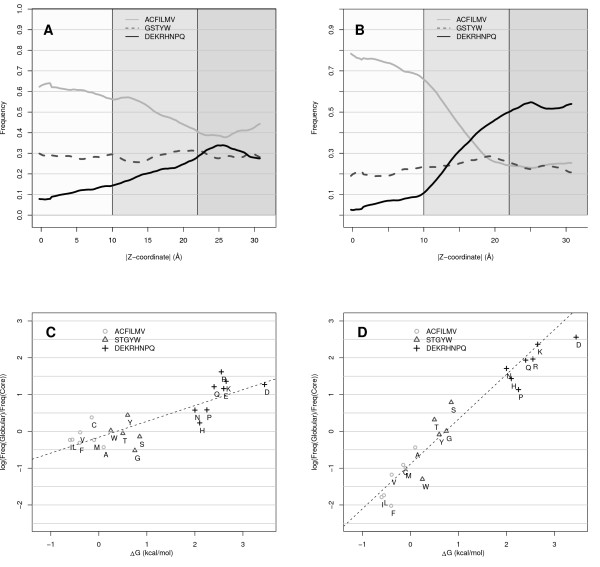
Amino acid distribution and solvent accessibility. The incidence of three different classes of amino acids as a function of distance from the membrane center. A) The subset of residues that have accessibility lower or equal to 25% (buried). B) The subset of residues that have accessibility higher than 25% (exposed). The coloring differentiates between polar, intermediate and hydrophobic residues. The two lower figures show the log of the difference in substitution rates between the globular and membrane regions plotted against the biological hydrophobicity value for each amino acid type. In C) the rate for buried sites is shown while in D) the rate for exposed sites is shown.